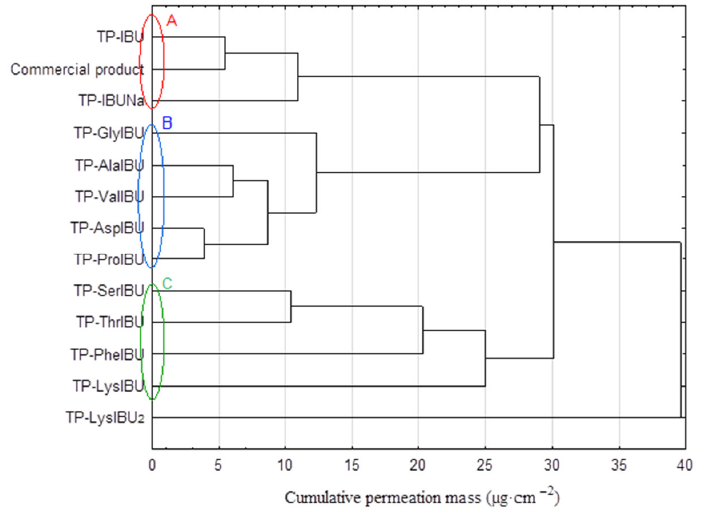
Figure 6. Cluster analysis graph for the mean accumulated mass of IBU and its derivatives during the entire 24 h study. Compounds with similar values are marked with a different color circles (A, B, C).